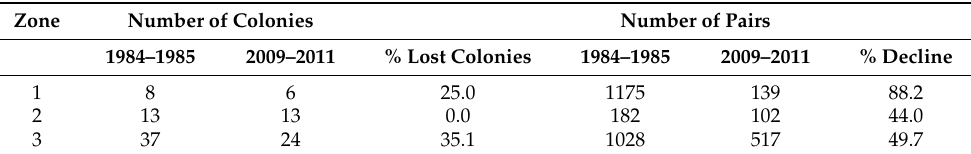
Figure 3. Trends in the number of breeding pairs of jackdaws nesting in each cliff sector ( A – D ) in Madrid province, Central Spain (see Figure 1 for location of the cliffs).